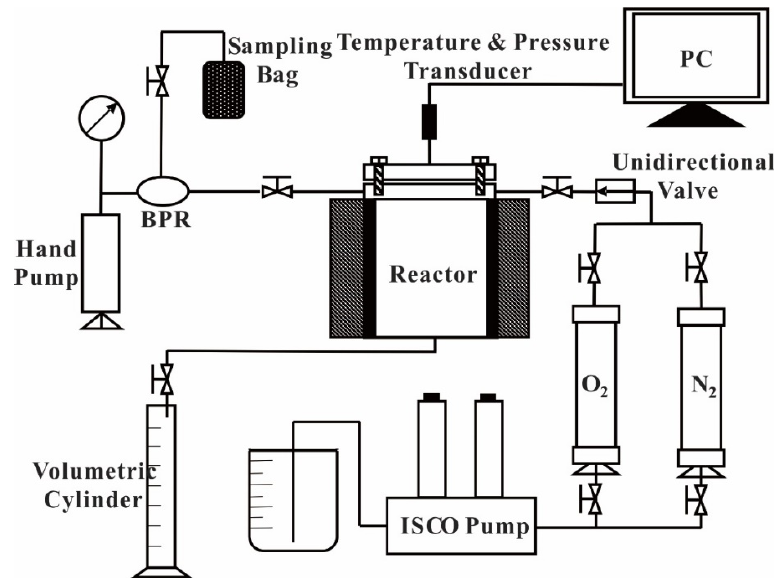
Figure 4. The flow chart of supercritical multi-thermal fluid generation experiment.